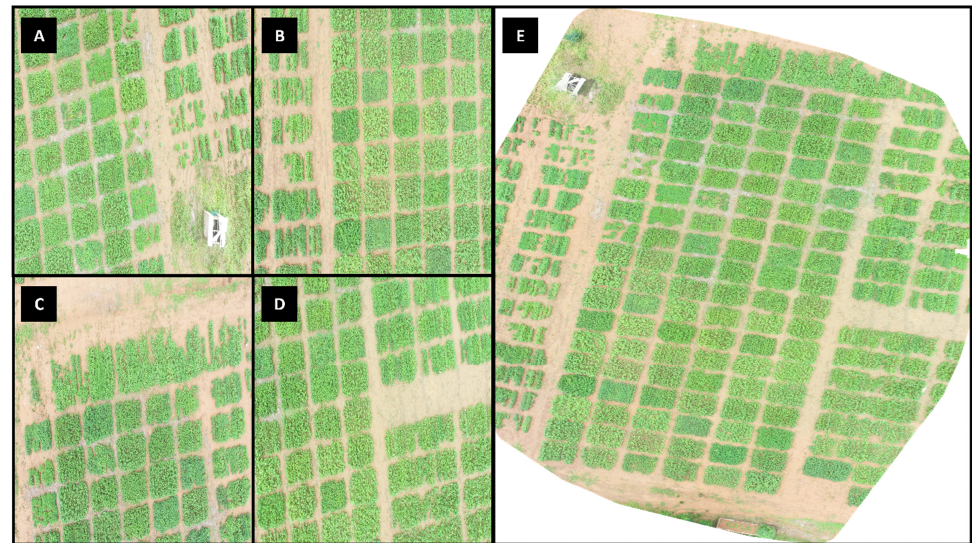
Figure 1. Individual images from the drone ( A – D ) and the reconstructed field ( E ). Downstream data extraction from the orthomosaic images were performed after We- bODM processing using UAStools, QGIS and FIELDimageR [37,38]. UAStools was used to create a shapefile for each experiment comprising of individual plots. Each plot in the shapefile had an area of 4 m 2 . Out of the ground area of 6.4 m 2 , all plants in an area of 4 m 2 excluding the plot border rows was sampled for HTPP data capture. The alignment of plots in the shapefile with that of the orthomosaics was checked in QGIS and corrected where necessary to ensure that only inner portions of the plots were sampled. Shapefile alignment for each flight mission within a year was performed from georeferenced ortho- mosaics. Plot data were extracted from the orthomosaic images in conjunction with the shape- file using FIELDimageR. Since estimation of vegetation indices is on a pixel basis with which background soil could interfere, soil in the background was removed using the overall hue index (HUE) [39]. The original HUE has been modified in FIELDimageR to better capture soil color. After soil removal, the proportion of ground covered by plant canopy (canopy cover) was estimated from the true plant canopy remaining. Then the individual pixels of red, green and blue color channels were divided by 255 to convert them into a 0–1 scale. After scaling, the pixelated values were used to estimate the nor- malized green red difference index (NGRDI, Equation (1)) and visible atmospherically resistant index (VARI, Equation (2)). NGRDI has been found to be highly associated with leaf chlorophyll content, biomass and water content of the plants [40], whereas VARI was associated with canopy, biomass and chlorophyll content [41]. Green area (GA, propor- tion of pixels with hue value of between 60 and 180°), greener area (GGA, proportion of pixels with hue value of between 80 and 180°) and crop senescence index (CSI, Equation (3)) were estimated using BreedPix [42,43]. BreedPix is a JRE-based plugin that analyses individual plot images. As a result, the reconstructed image, as shown in Figure 1E, cannot be directly analyzed to obtain individual plot data. Hence, a custom function was written in R statistical software (which can be obtained from the corresponding author) to crop out the individual plots from the preprocessed orthomosaics using the shapefile. 𝑁𝐺𝑅𝐷𝐼 = 𝐺 − 𝑅 𝐺 + 𝑅